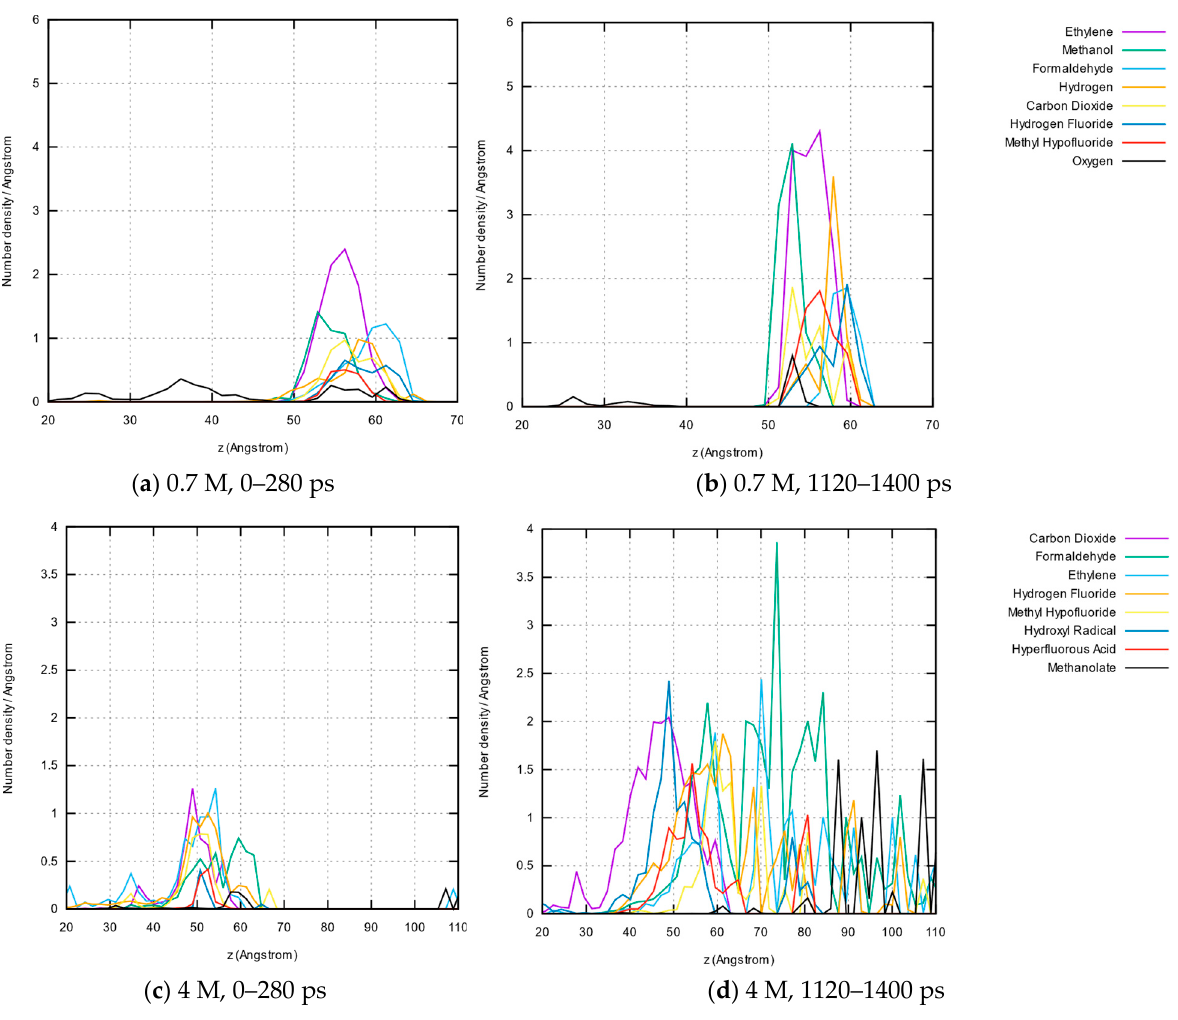
Figure 12. Space-resolved concentrations of the most abundant eight molecule species averaged over the first and last fifth of the overall dynamics. Shown are the results for 0.7 M LiTFSI for 0–280 ps ( a ) and 1120–1400 ps ( b ) as well as for 4 M LiTFSI for 0–280 ps ( c ) and 1120–1400 ps ( d ).